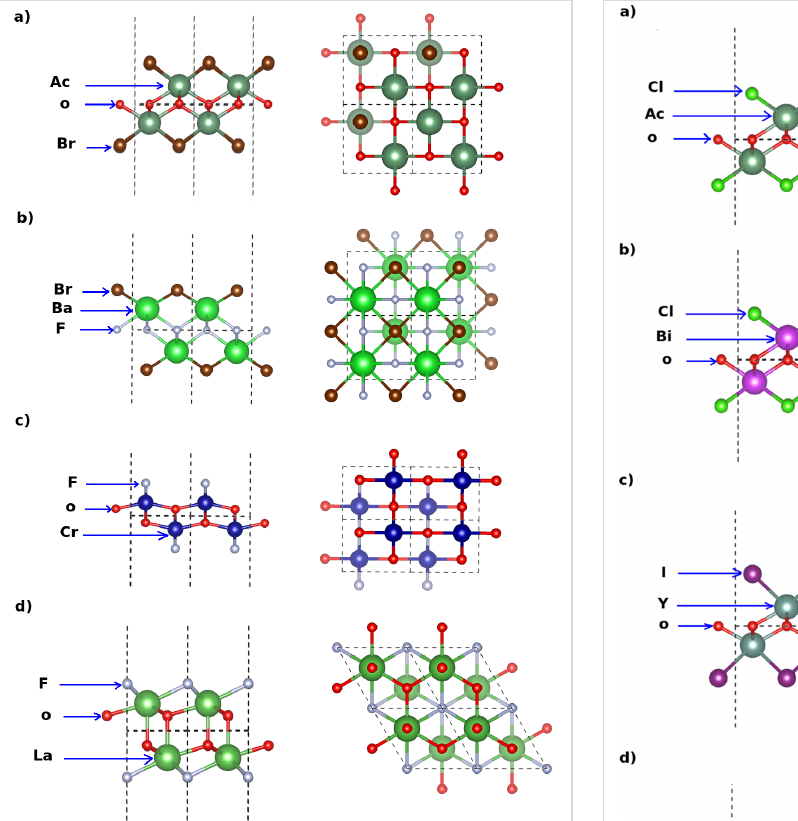
Figure 1: Side and top views of the crystal structures of a monolayer of: (a) AcOBr, (b) BaFBr, (c) CrOF and (d) LaOF.